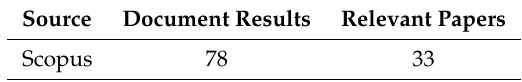
Table 4. Document search results and relevant selected